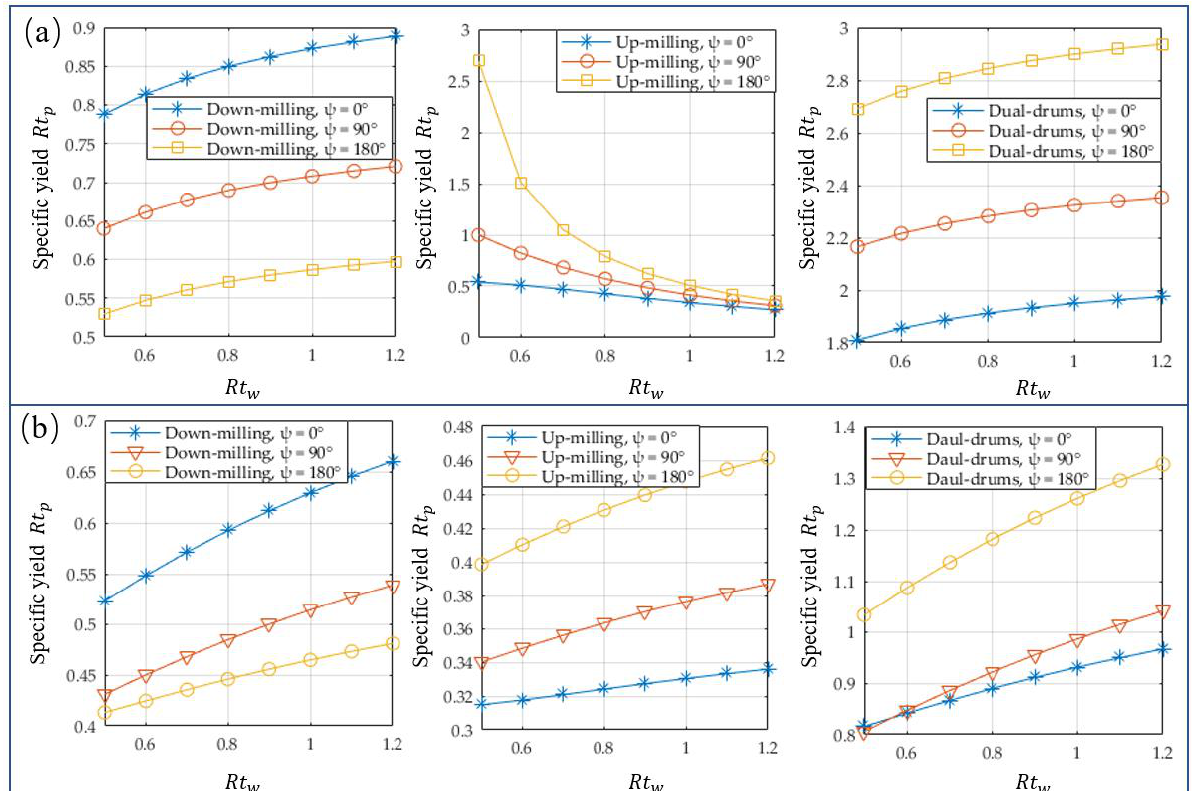
Figure 12. Influence of ratio of track width ( 𝑅𝑡 𝑤 ) on the stability. ( a ) Anti-slip stability condition; ( b ) anti-skid stability condition.